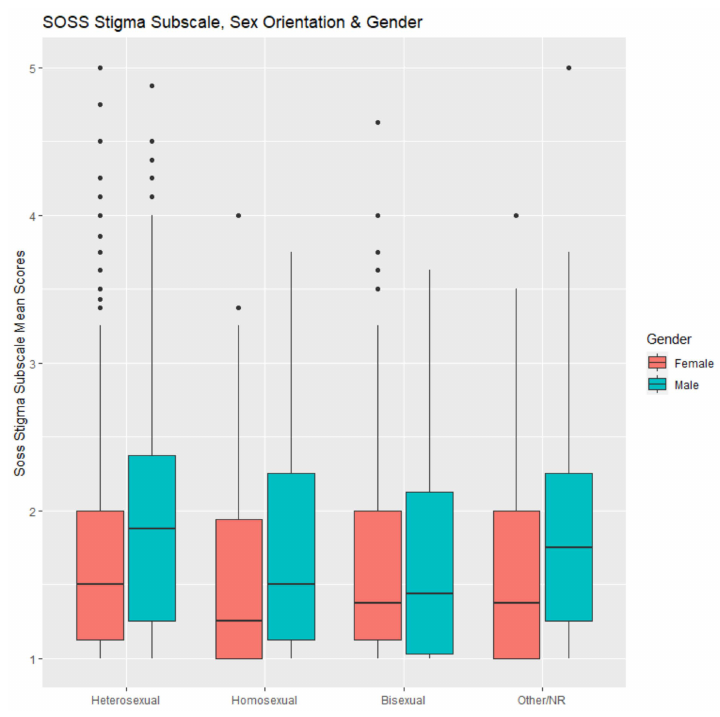
Figure 1. Boxplot of mean stigma scores by sexual orientation and